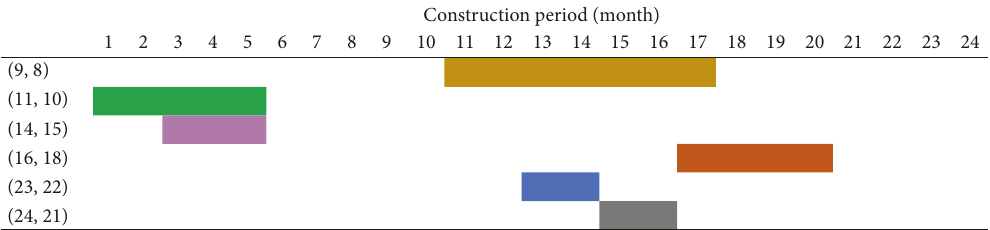
Figure 10: Illustration of the scheduling results for Example 2 .